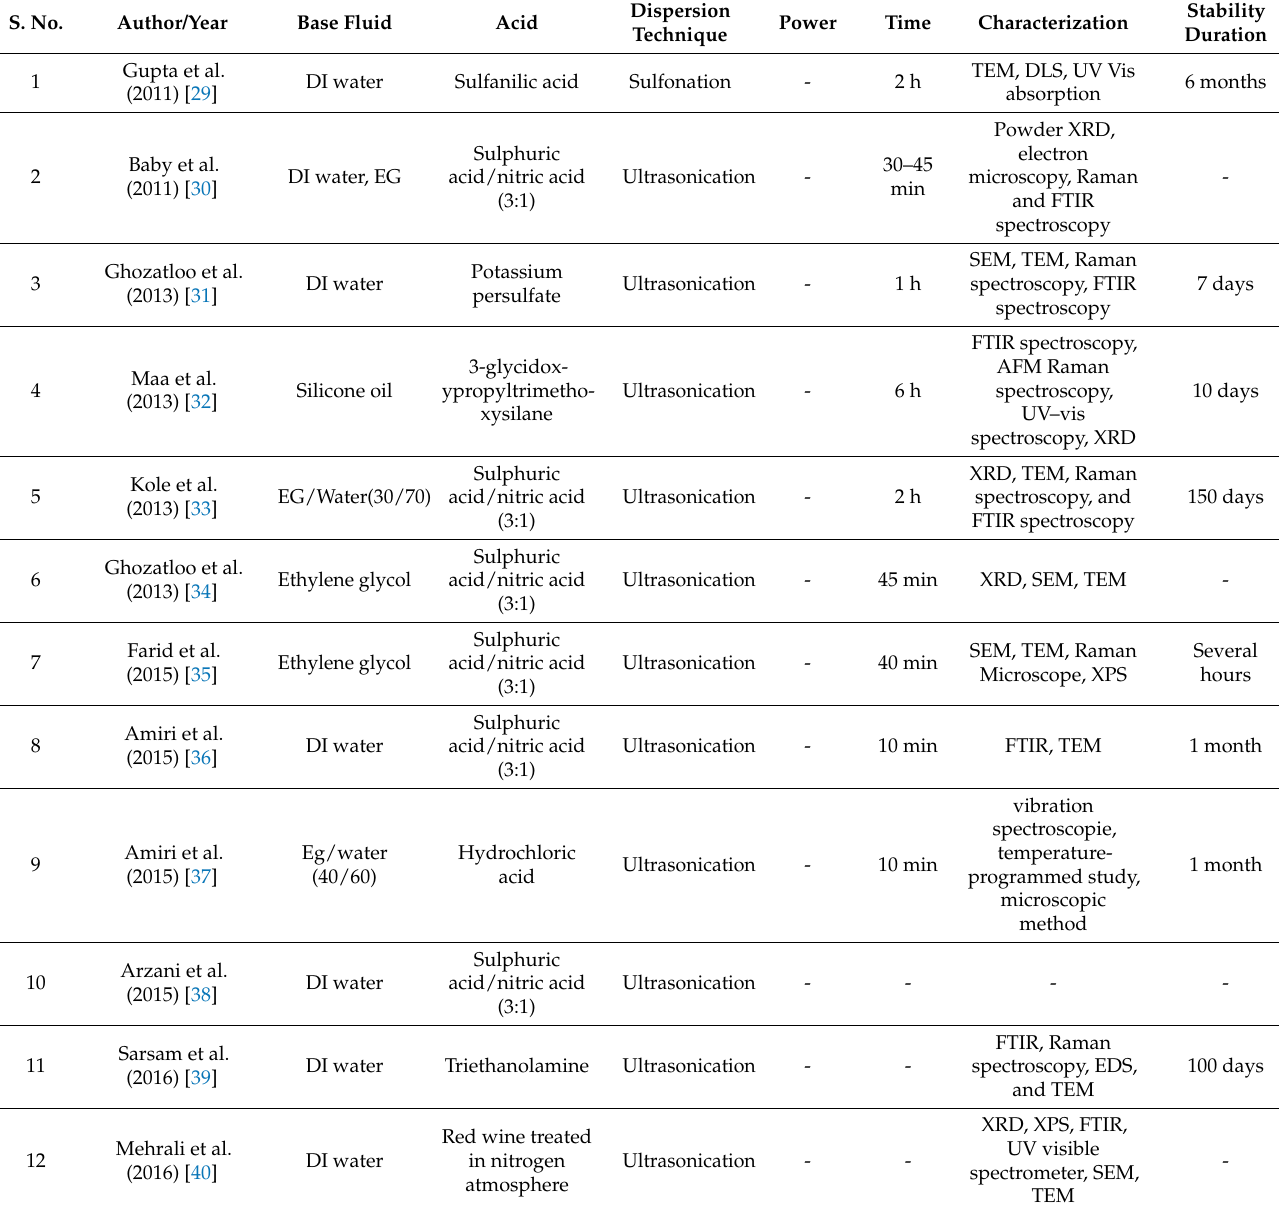
Table 5. Summary of published literature on synthesis of graphene nanofluids by the covalent